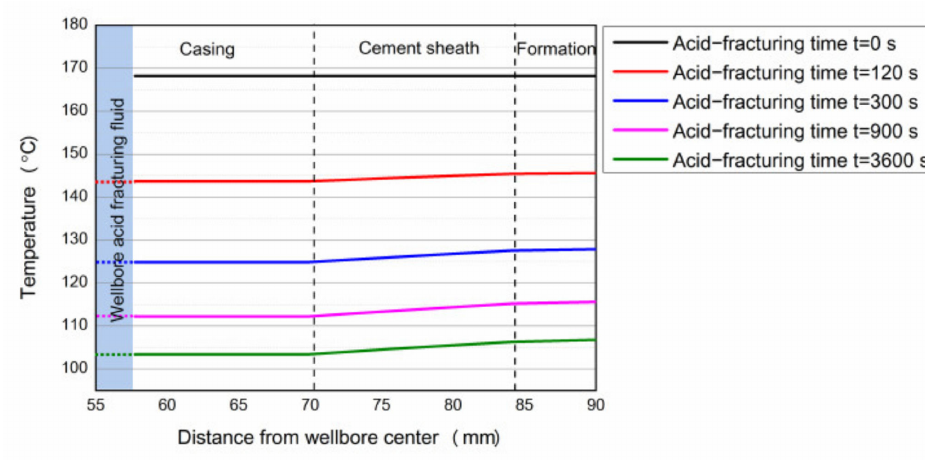
Figure 9. Wellbore temperature and temperature distribution of the cement